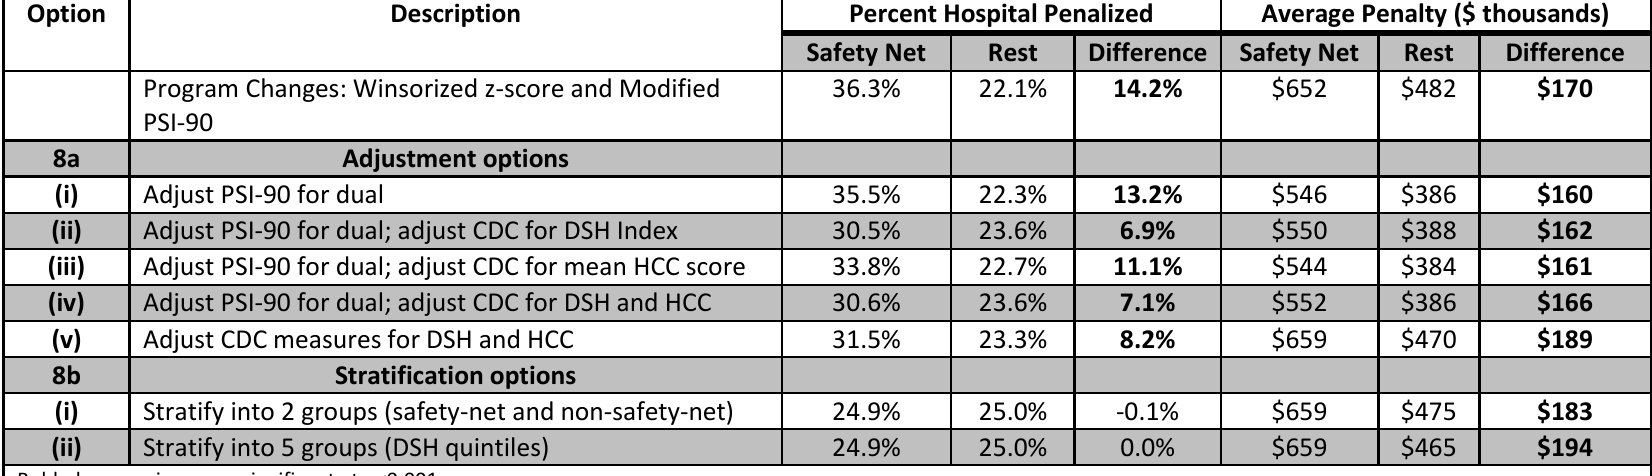
Table 6.26c Program Changes, Plus Policy Options (adjustment, stratification) – Safety-Net Versus Other Hospitals